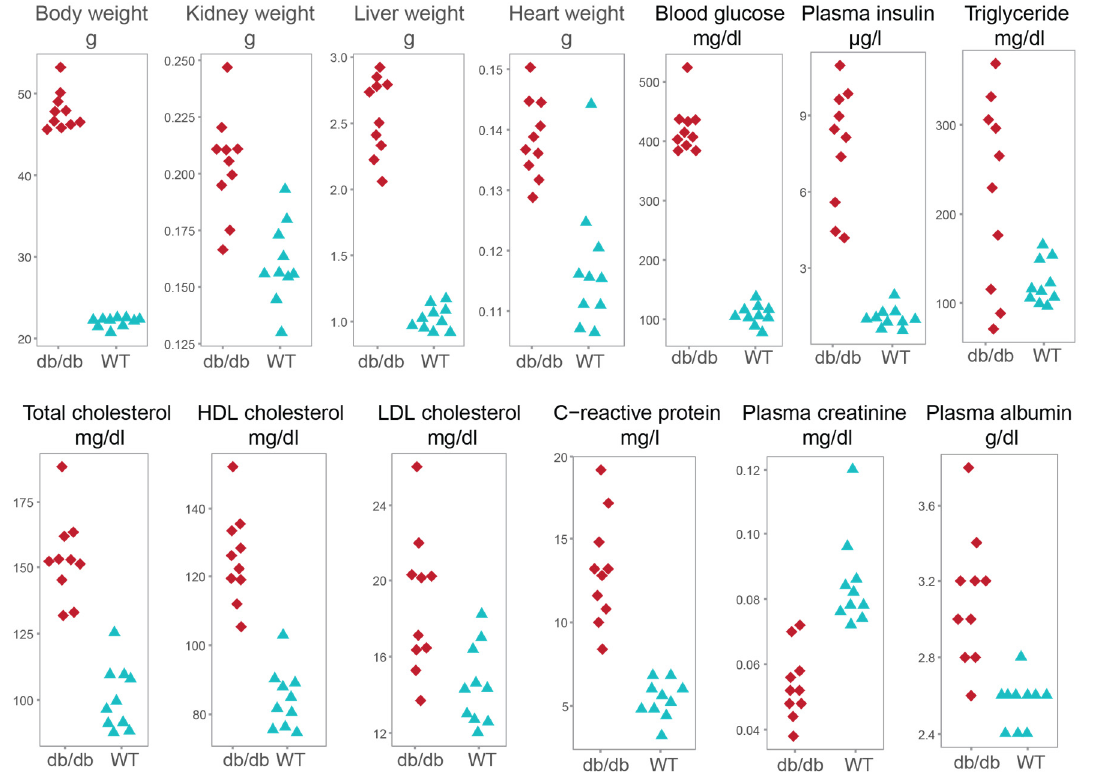
Figure 4. Scatter plots of phenotypic and metabolic variables in db/db and wild type mice fed with a high-fat diet. Abbreviations: HDL, high-density lipoprotein; LDL, low-density lipoprotein; db/db, leptin receptor-deficient mouse model; WT, wild type